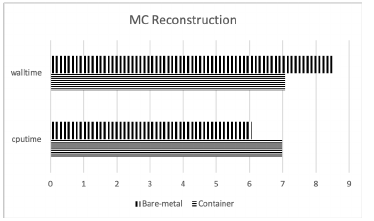
Figure 8. Timing comparison for AOD making test.